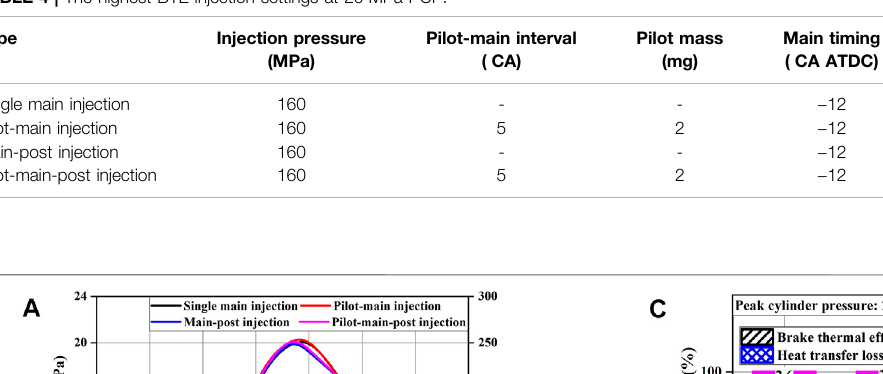
TABLE 4 | The highest BTE injection settings at 20 MPa PCP.